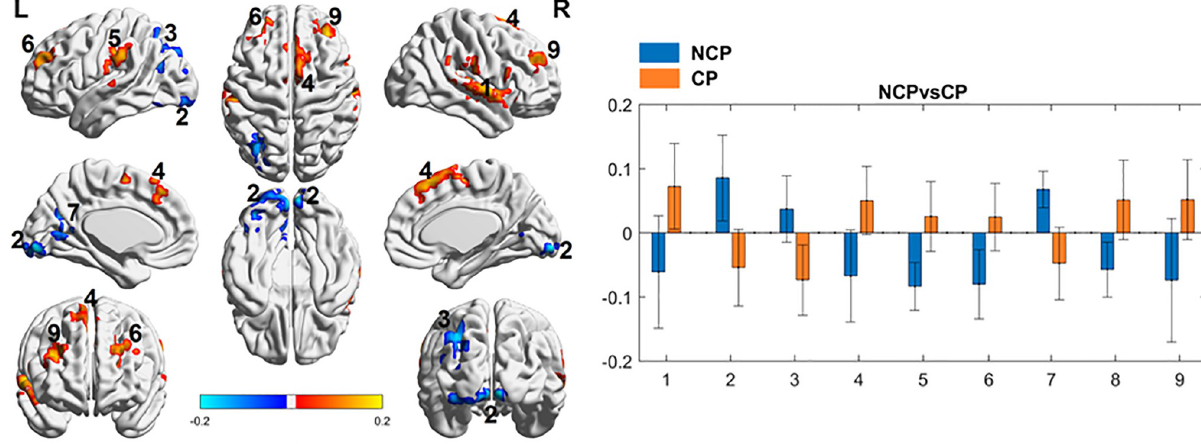
Fig 3. Periaqueductal gray (PAG) seed-based functional connectivity (FC) analyses between patients with SCD with chronic pain (CP) and without chronic pain (NCP). Left : Images show the results of the two sample t-test pattern of NCP (SCD patients without chronic pain, blue) and patients with chronic pain (SCD patients with sickle cell disease and chronic pain, orange) PAG FC, respectively. Color is coded based on z-score of the significance. Brain regions with warm color represent the positive connection and cold color represents the autocorrelation with PAG regions. Brain regions are numbered: (1) right superior temporal gyrus/ right insula/ right postcentral gyrus/ right inferior parietal lobule, (2) left lingual gyrus/ left inferior occipital gyrus/ left middle occipital gyrus, (3) left middle temporal gyrus/ left precuneus/ left inferior parietal lobule/ left superior parietal lobule, (4) left and right superior frontal gyrus (right most)/ medial frontal gyrus, (5) left supramarginal gyrus, (6) left superior frontal, (7) left posterior cingulate cortex, (8) right culmen of the cerebellum, and the (9) right middle and superior frontal lobe. Right : In comparison to NCP, patients with chronic pain demonstrated increased connectivity in the (1) right superior temporal gyrus/ right insula/ right postcentral gyrus/ right inferior parietal lobule, (4) left and right superior frontal gyrus (right most)/ medial frontal gyrus, (5) left supramarginal gyrus, (6) left superior frontal, (8) right culmen (cerebellum), and the (9) right middle and superior frontal lobe. Decreased connectivity was noted in the (2) left lingual gyrus/ left inferior occipital gyrus/ left middle occipital gyrus, (3) left middle temporal gyrus/ left precuneus/ left inferior parietal lobule/ left superior parietal lobule, and (7) left posterior cingulate cortex (y-axis = z-score of the significance, x-axis = brain region of interest by number).